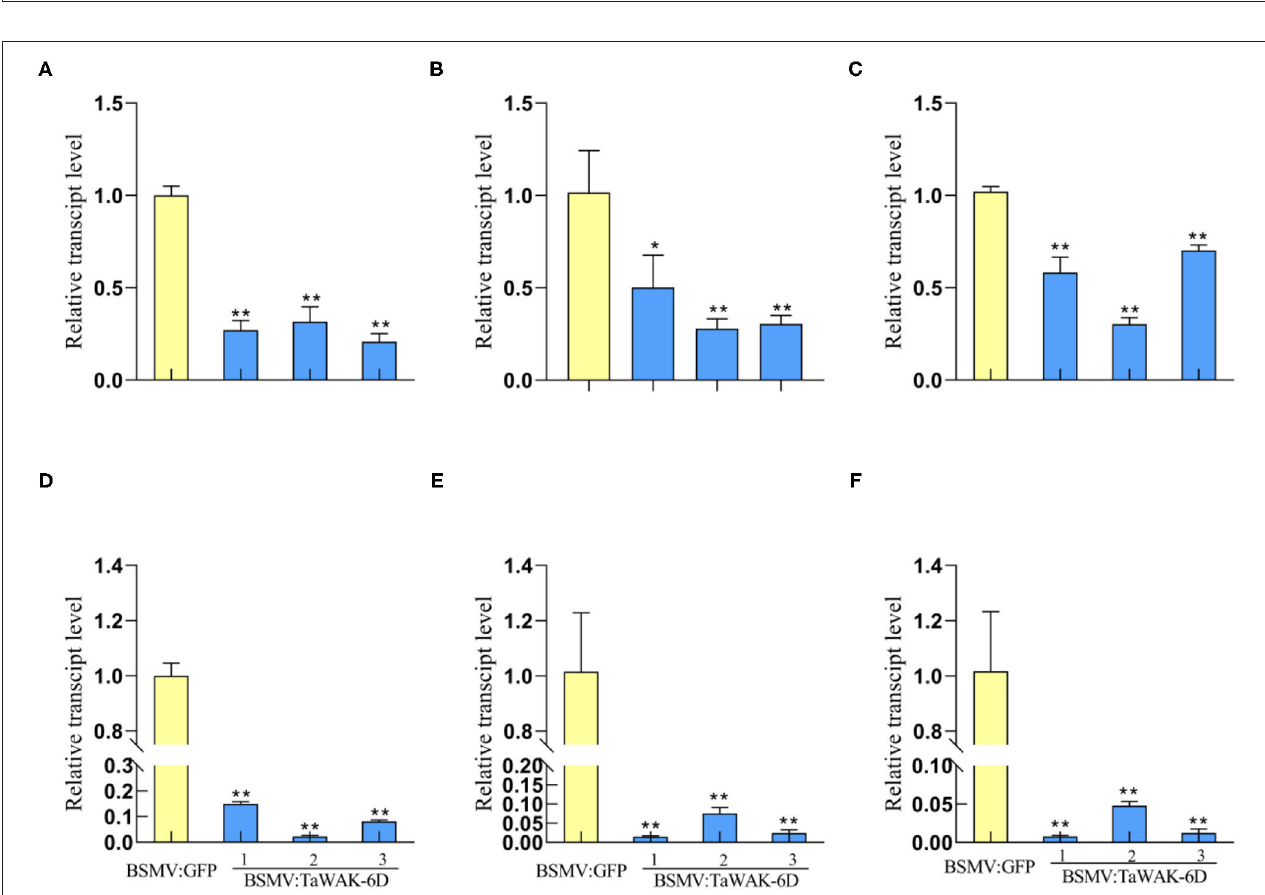
FIGURE 5 | TaWAK-6D in TaWAK-6D -silencing and BSMV: GFP-infected wheat CI12633 plants. The transcript level of TaWAK-6D in BSMV: GFP- infected wheat CI12633 plants was set to 1. Significant differences were determined based on three technical repeats ( t -test: ** P < 0.01). (C) Sharp eyespot symptoms on TaWAK-6D silencing and control CI12633 plants at 35 dpi with R. cerealis . Disease severity was indicated by infection type (IT). (D) Mean IT of TaWAK-6D silencing or control CI12633 plants at 35 dpi with R. cerealis in two independent batches ( t -test: ** P < 0.01). Bars indicate SEs of the mean. (E) FCR symptoms of BSMV: TaWAK-6D or BSMV: GFP CI12633 plants after inoculated with F. pseudograminearum for 30 days. The IT was used to indicate the disease severity of each seedling (F) Mean ITs of BSMV: TaWAK-6D or BSMV: GFP CI12633 control seedlings at 30 dpi with F. pseudograminearum in two independent batches ( t -test: ** P < 0.01). Bars indicate SEs of the mean.